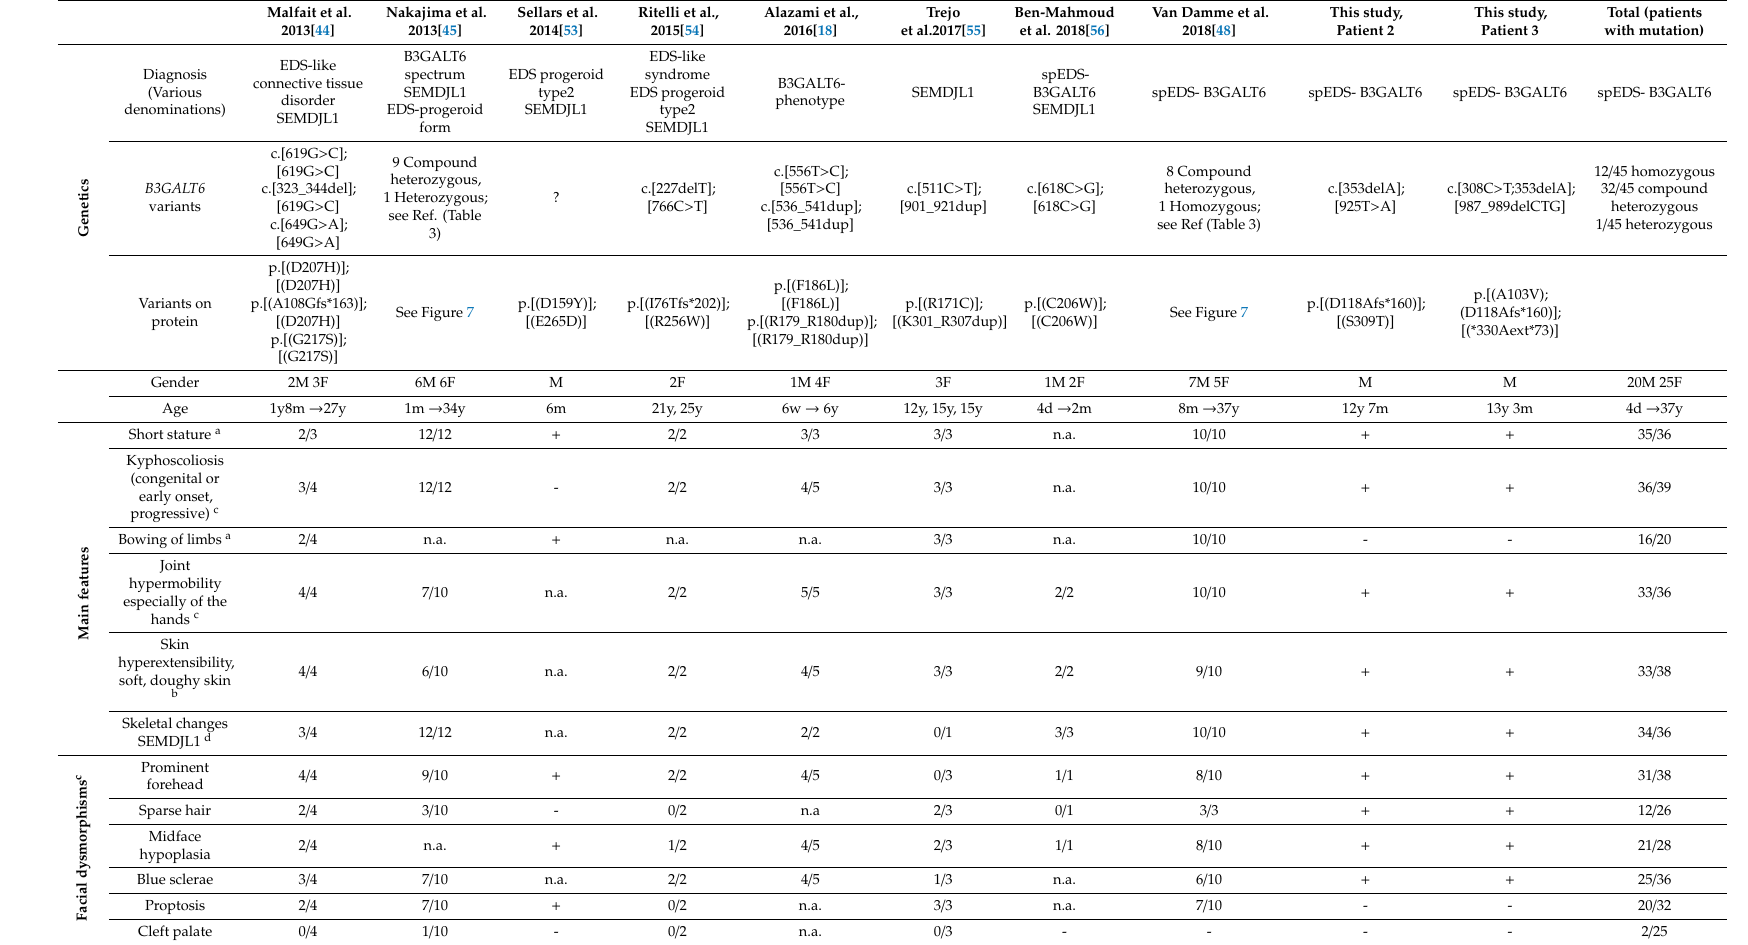
Table 2. Patients with B3GALT6 variants: Review of the